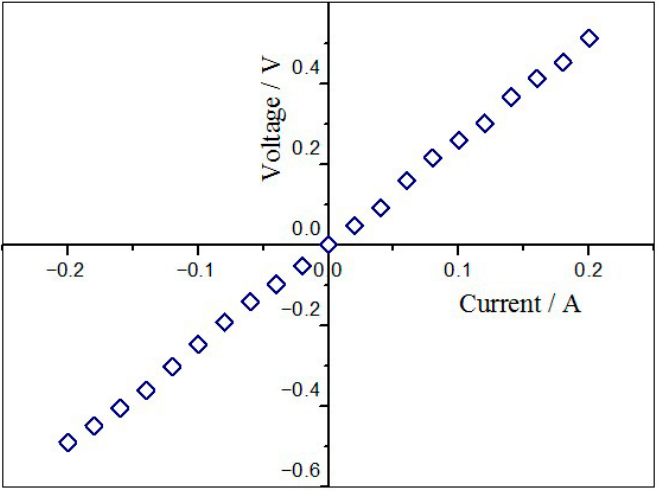
Figure 7. I–V curves of electroless deposited copper patterns on the composite films of FP/PAN.